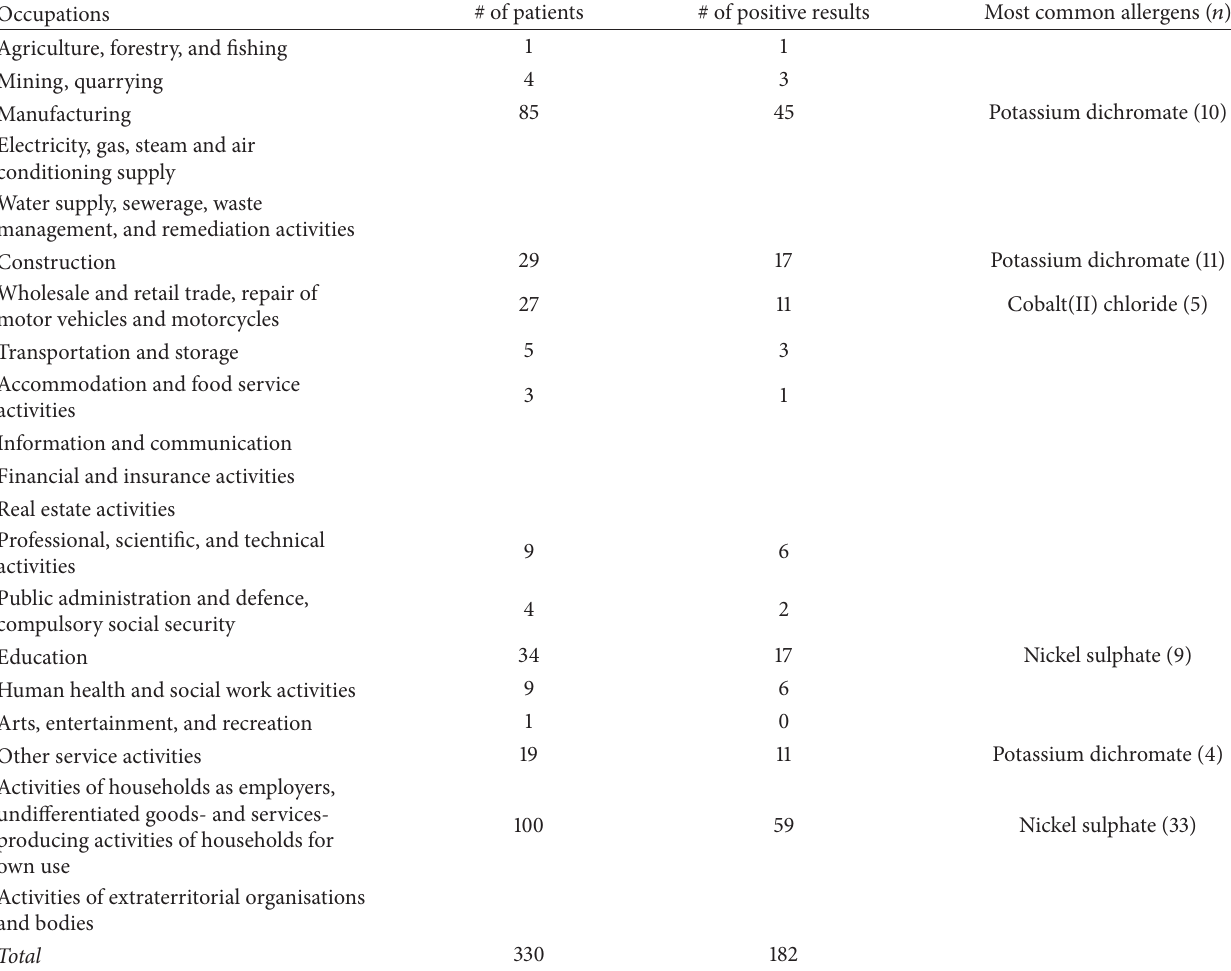
Table 2: Comparison of occupations according to NACE codes and patch test